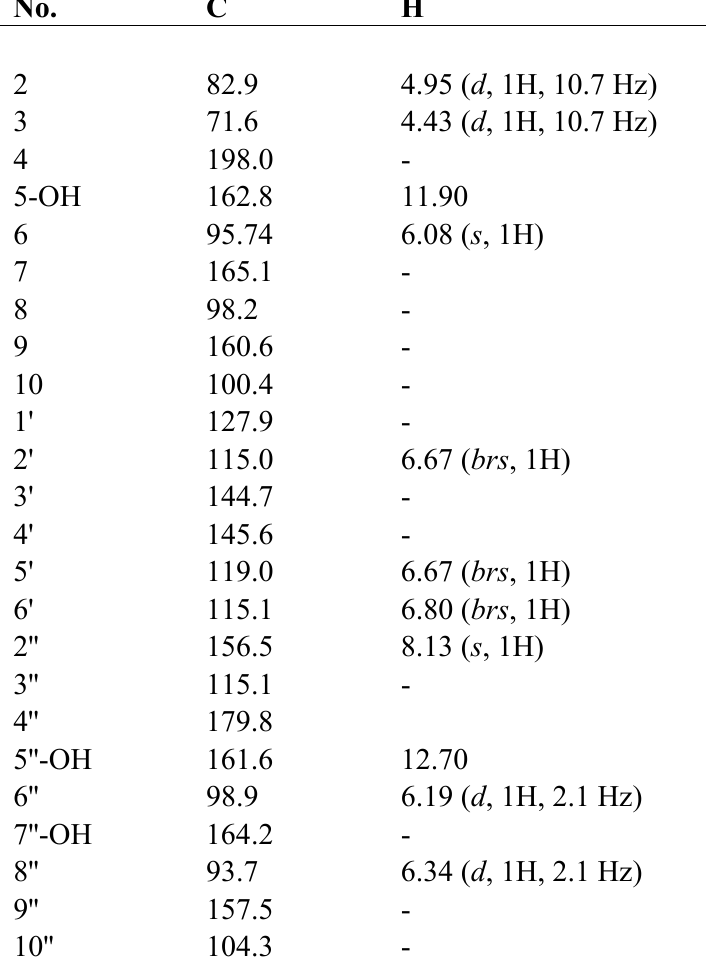
Table 4. 1 H- and 13 C-NMR data of compound 1 (recorded at 500/125 MHz in DMSO- d δ 25 °C, ppm; J ,